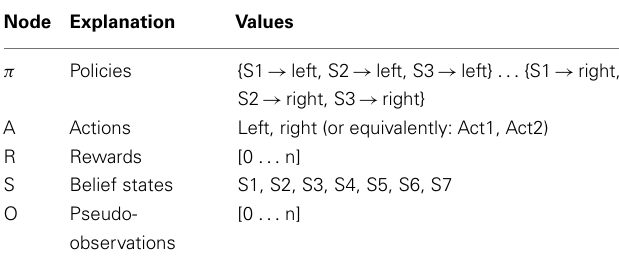
Table 1 | Nodes of the graphical model of Figure 3.